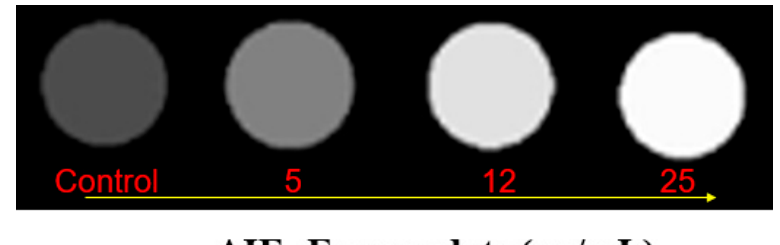
Figure 5. T1 weight images of AIE–Fe nanodots (with a 5 wt % TPAS loading).